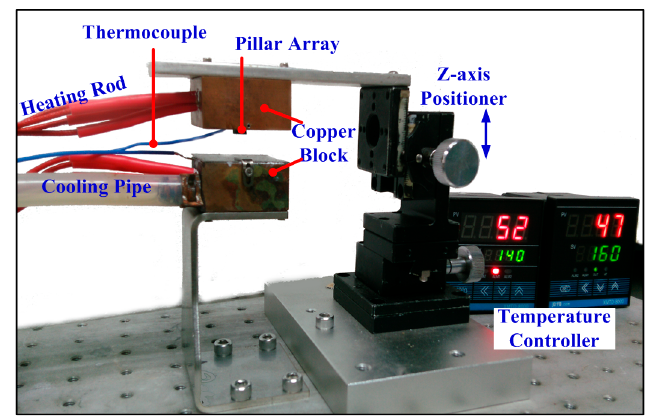
Figure 1. Thermal drawing setup for MA.